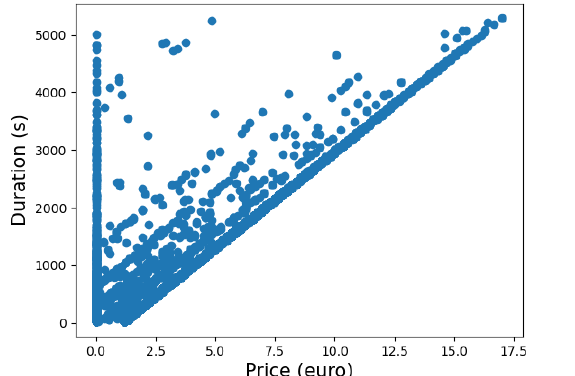
Figure 2. Time spent on vehicles (y) vs. money paid (x).